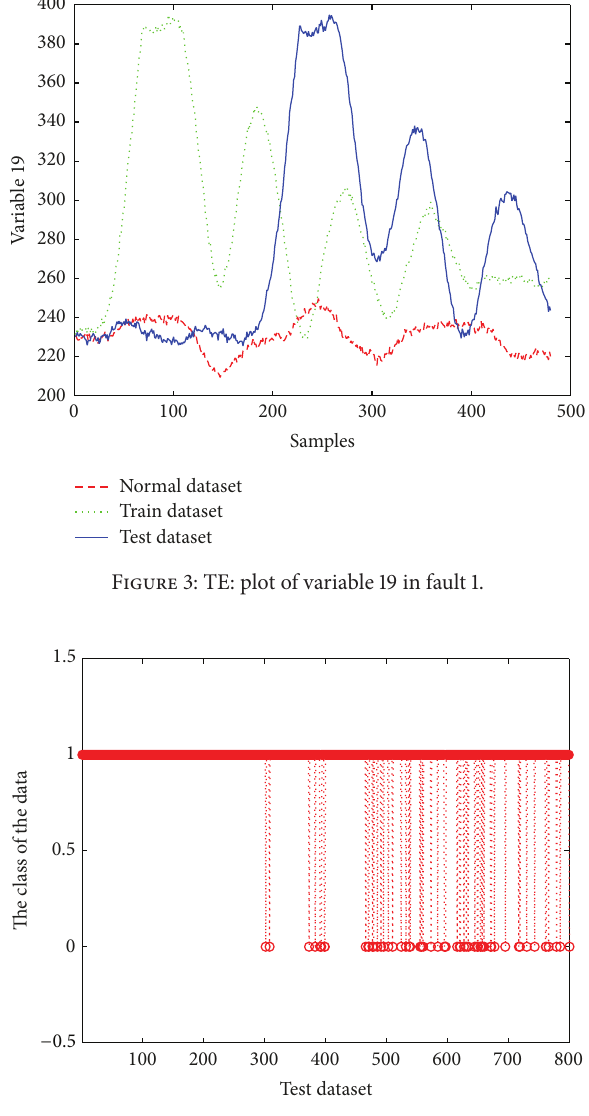
Figure 4: The SVM for fault detection for fault